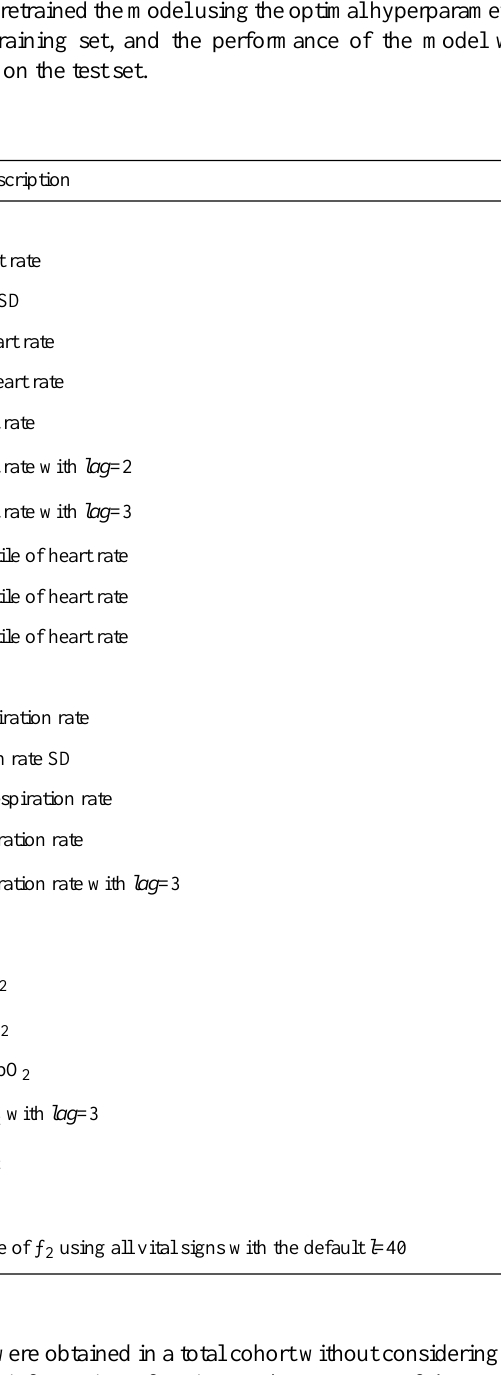
Table 1. Statistical features constructed in this study.